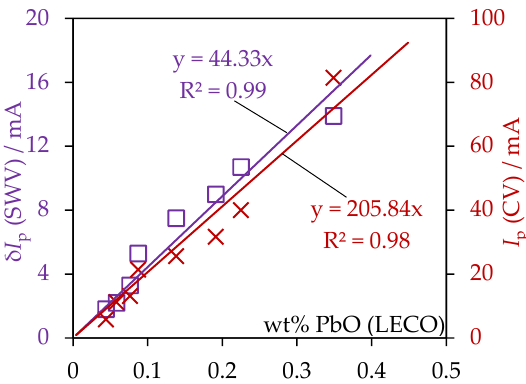
Figure 9. Dependences of the peak values of the anode current of the current-voltage dependences on the PbO concentration in the PbCl 2 –PbO melt.